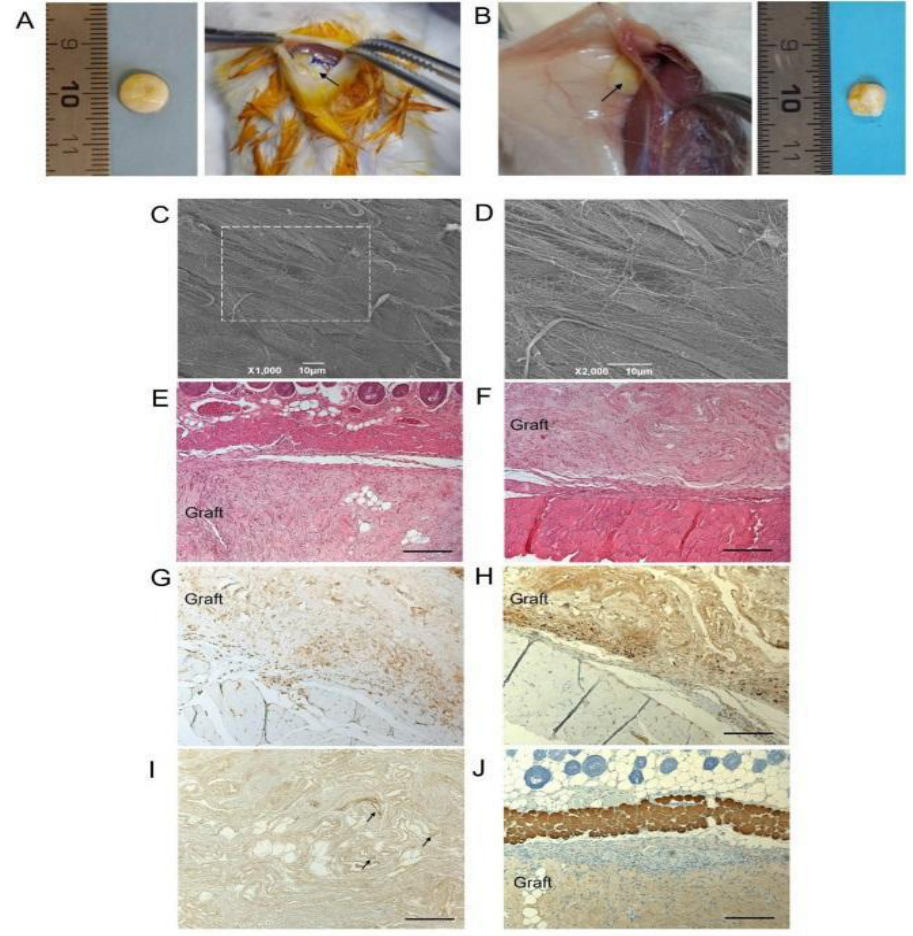
Figure 5. Decellularized human diaphragm integration in host tissue. ( A ) Discoidal sample was implanted subcutaneously anchored to the dorsal muscle of BALB/c mice. ( B ) Sample excision after 14 days. ( C , D ) Ultrastructural analysis by SEM. ( E ) Histological staining with haematoxylin and eosin at the graft – host interface on the subcutaneous and ( F ) deeper muscular side. The immunolocalization of ( G ) CD3+ and ( H ) F4/80+ cells at the boundaries between the graft and the host tissue confirmed moderate lympho-monocytic infiltration triggered by the scaffold graft. ( I ) Positivity to VEGF (black arrows) and ( J ) negativity to myosin within the diaphragmatic graft demonstrated an early angiogenetic, but not myogenetic, process after 14 days from implantation. Scale bar: 10 µm ( C , D ); 200 µm ( E – J ). Reproduced with permission [134]. Table 4. Comparison between conventional treatments and novel treatment. Conventional Treatment Novel